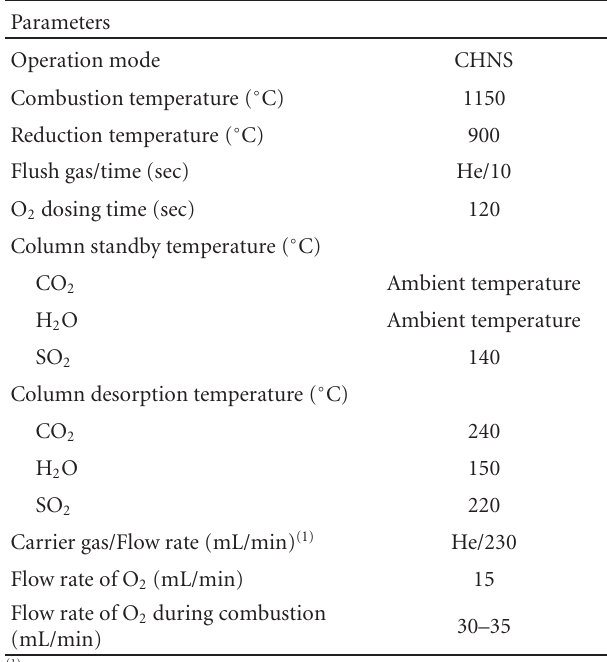
Table 1: Optimized parameters of elemental analyzer for quantita- tion of ECD in ECD